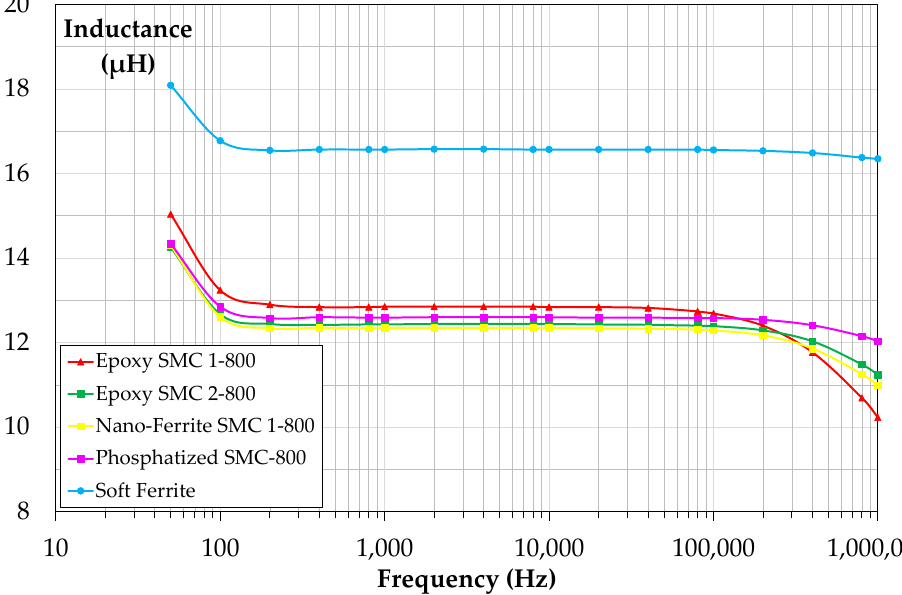
Figure 13. Inductance values of produced SMC and soft ferrite rod inductors in a frequency range up to 1 MHz .